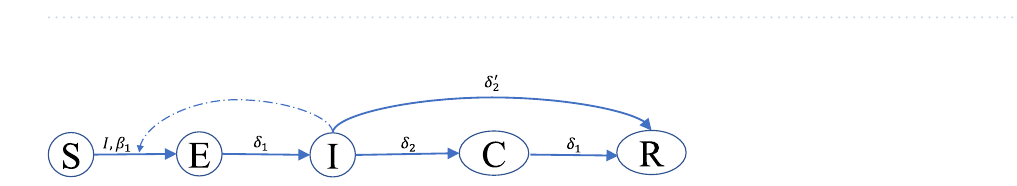
Figure 1. Degree distribution of the full network. In the network, households are at the node level. The network has 20,439 nodes and 445,350 edges. The average degree of this network is 43.647. The maximum degree in the network is 227.